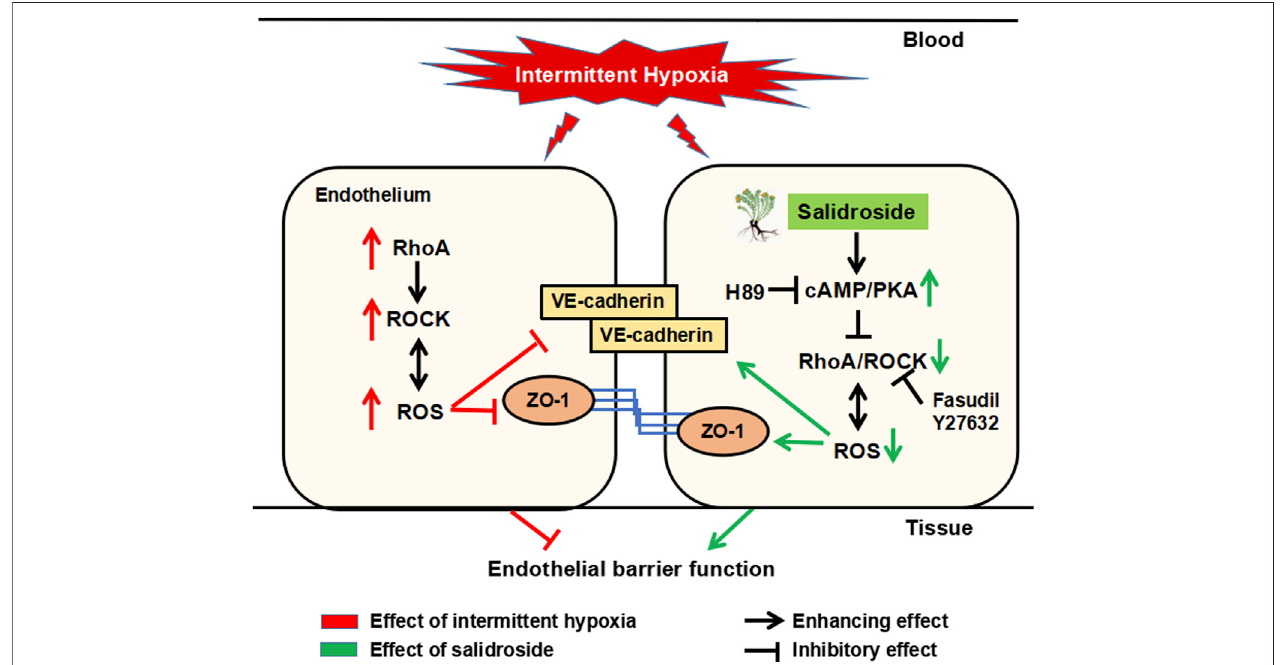
FIGURE 7 | Schematic diagram of the potential mechanism by which salidroside protects against IH-induced ROS overproduction and barrier disruption in the endothelium. Salidroside increased intracellular cAMP levels, which subsequently activated PKA in HUVECs. Activated cAMP/PKA suppressed IH-induced elevation of RhoA and ROCK, and thereafter inhibited ROS generation. In turn, reduced ROS production inhibited RhoA/ROCK expression, breaking the vicious cycle of ROS augmentation induced by IH in the endothelium. IH, intermittent hypoxia; ROS, reactive oxygen species; RhoA, ras homolog gene family member A; ROCK, Rho- associated protein kinase; PKA, protein kinase